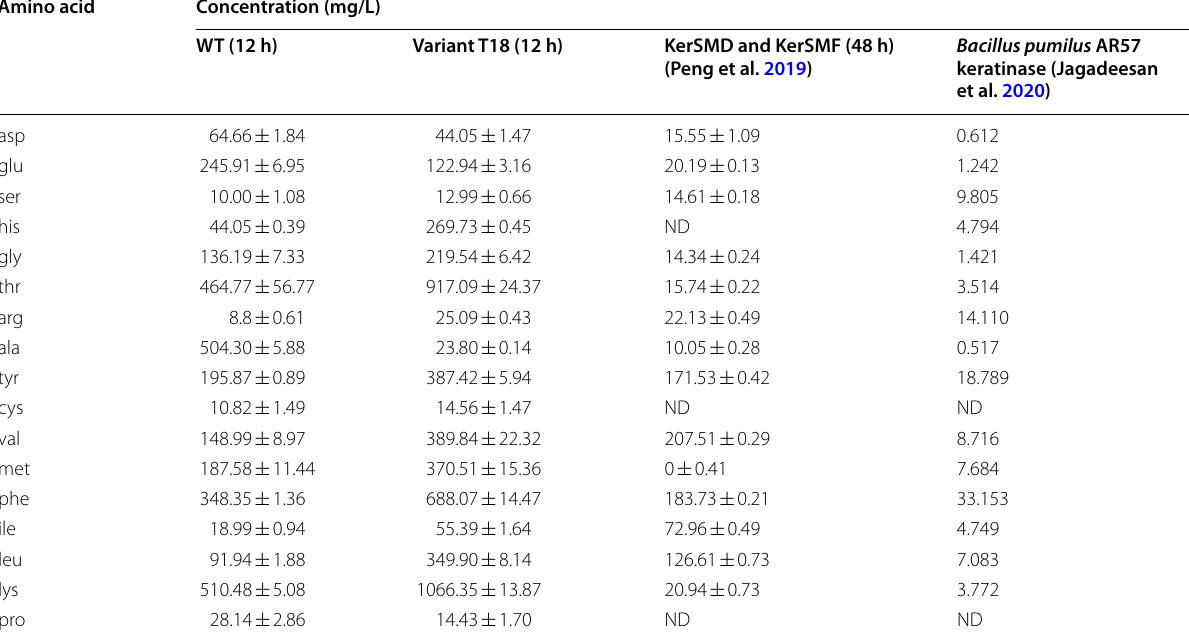
Table 3 Comparison of amino acids in feather degradation products Amino